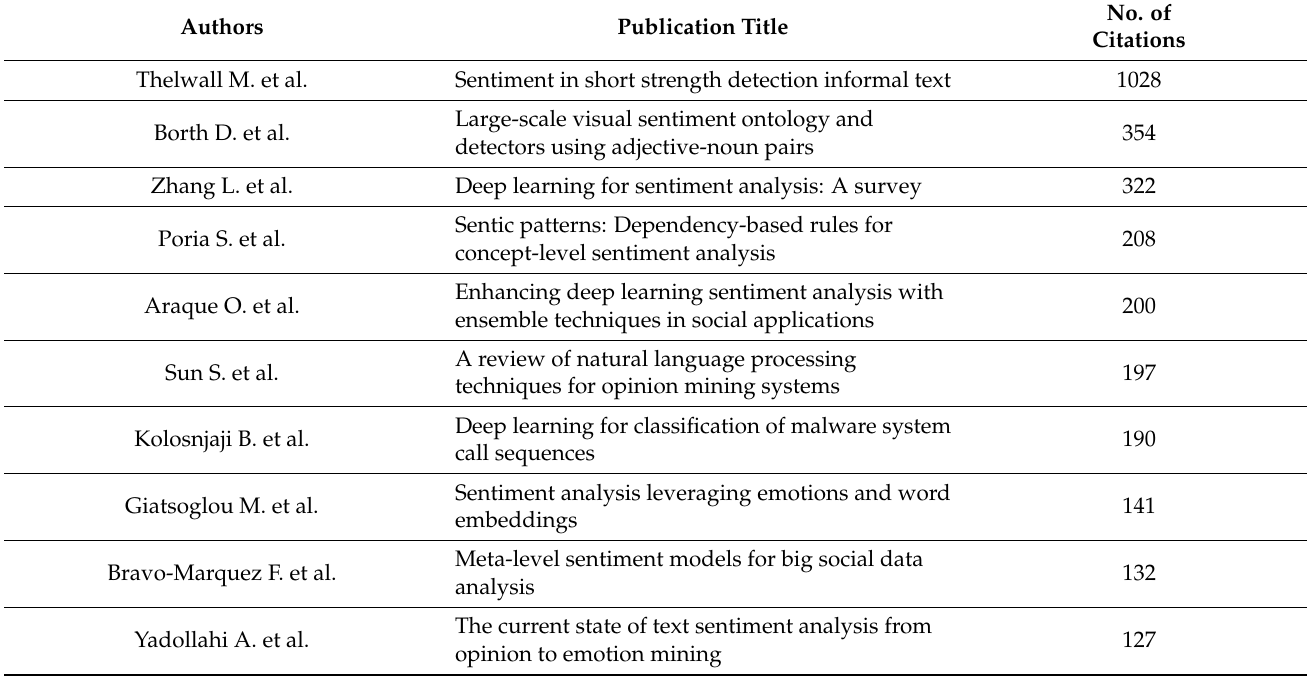
Figure 13. Network of highly cited authors with co-authors, source title, and publication title. Table 13. Top 10 most cited authors, publication title, and the number of